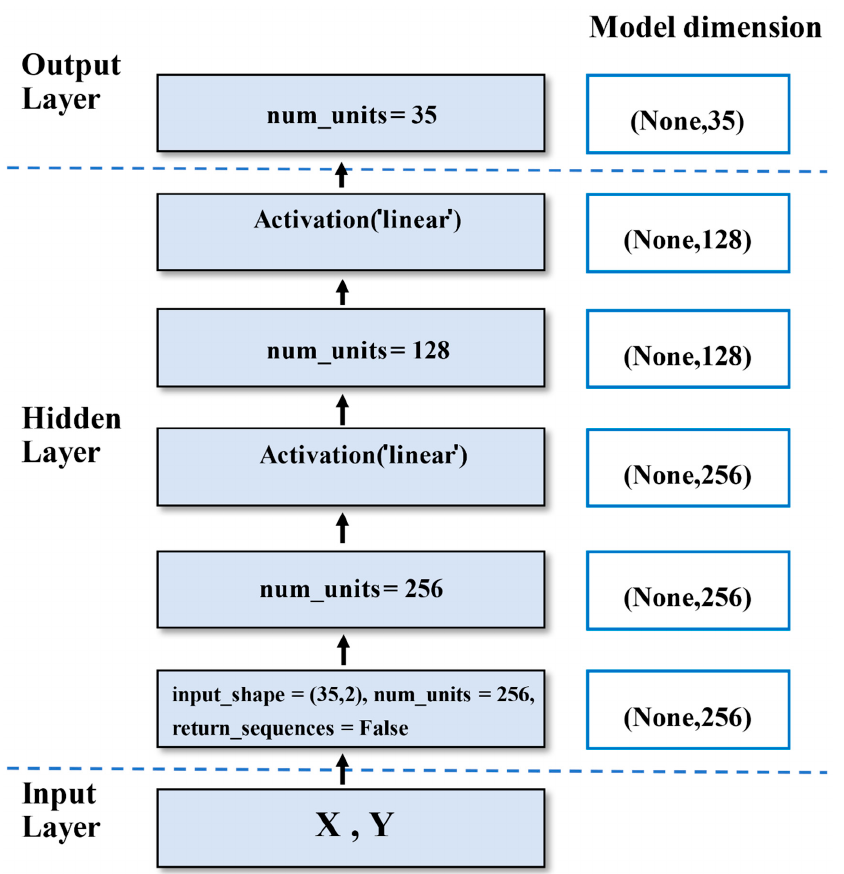
Figure A1. The model parameters of the car trajectory prediction we Figure 1. The model parameters of the car trajectory prediction we set.